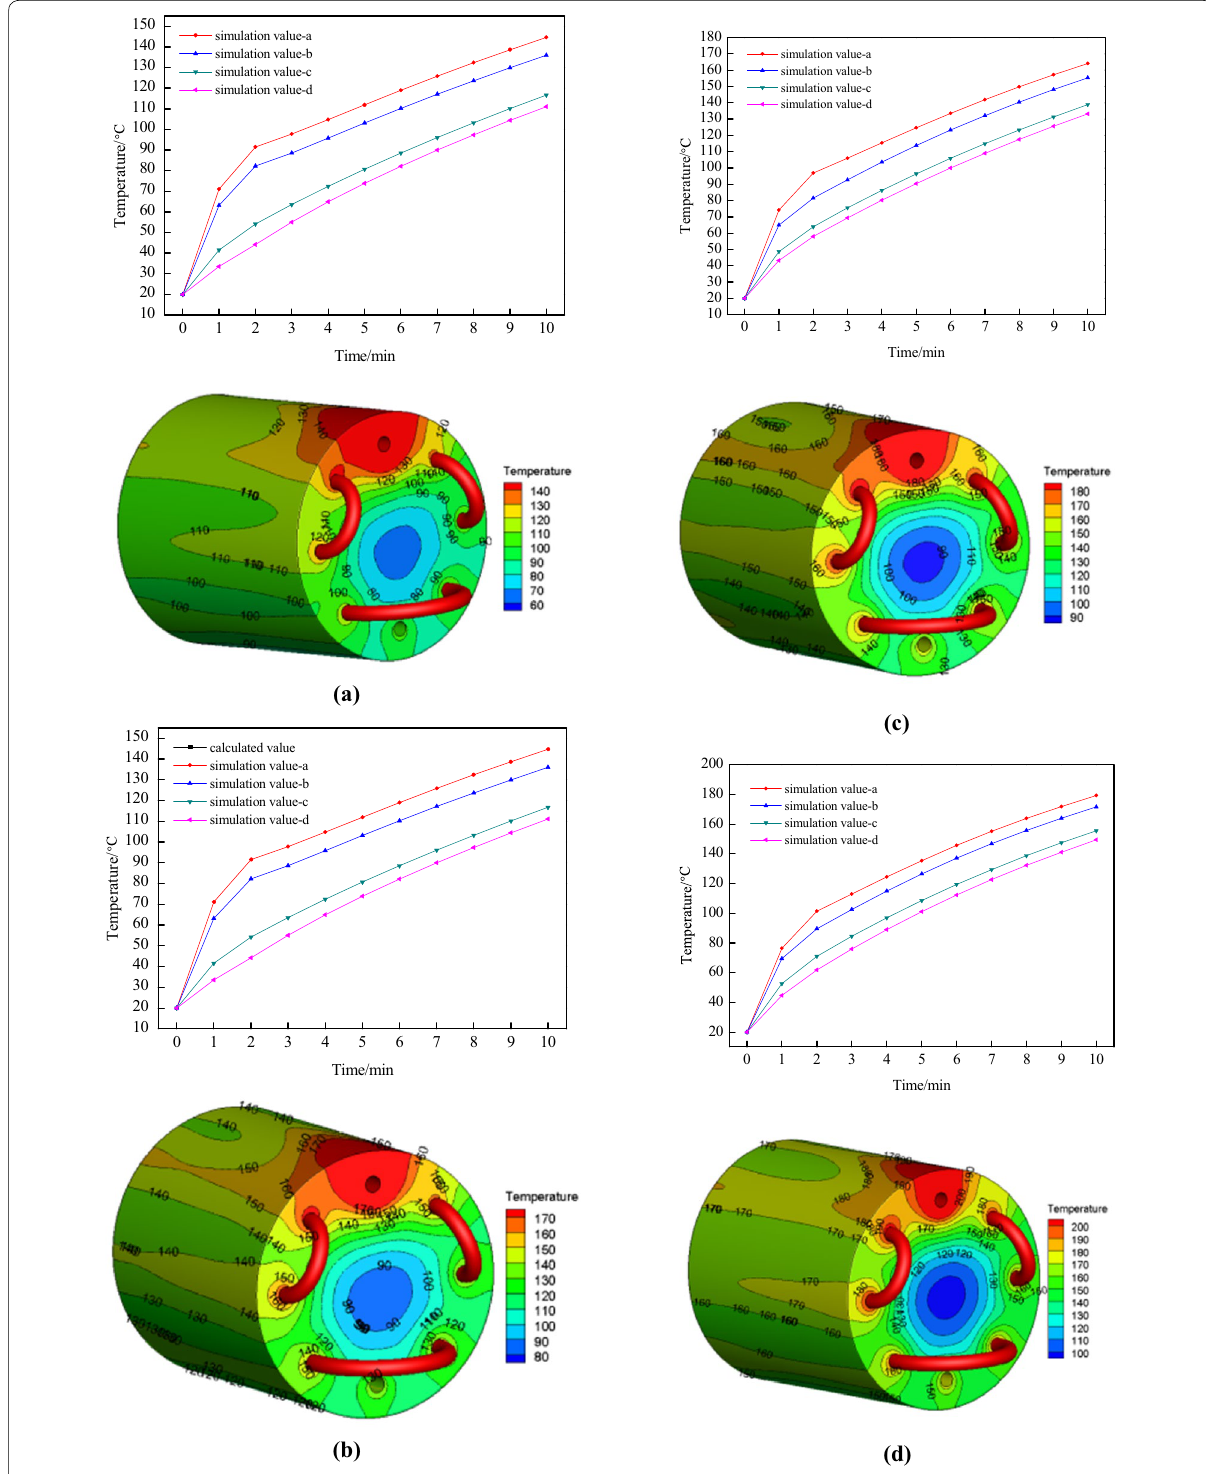
Figure 7 Temperature simulation value of the point a, b, c, and d, and the roll temperature field (after 10 min): a v v 0.7 m/s; d v 0.9 = =